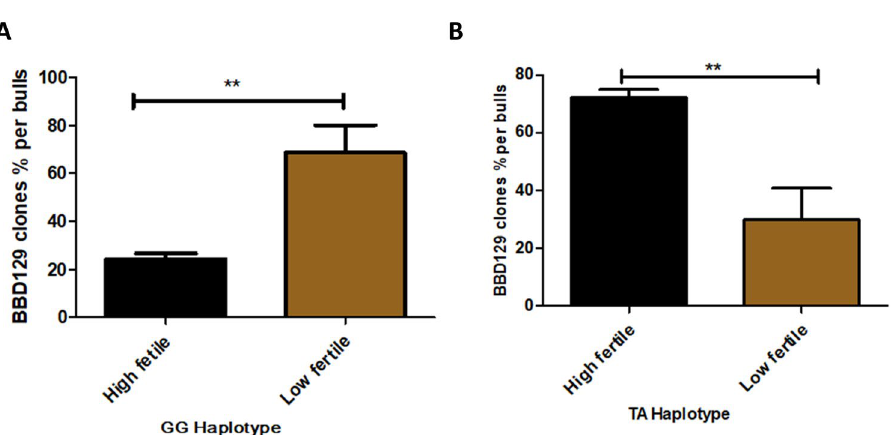
Figure 6. The BBD129 -TA haplotype and BBD129 -GG haplotype distribution in distinct fertility cross-bred bulls. The sequencing results have found that the cross-bred bulls produced a heterogeneous spermatozoa population bearing different haplotypes of the BBD129 gene. ( A ) BBD129 -TA haplotype was significantly more distributed in the high fertile bulls. ( B ) BBD129 -GG haplotype was significantly more distributed in the low fertile